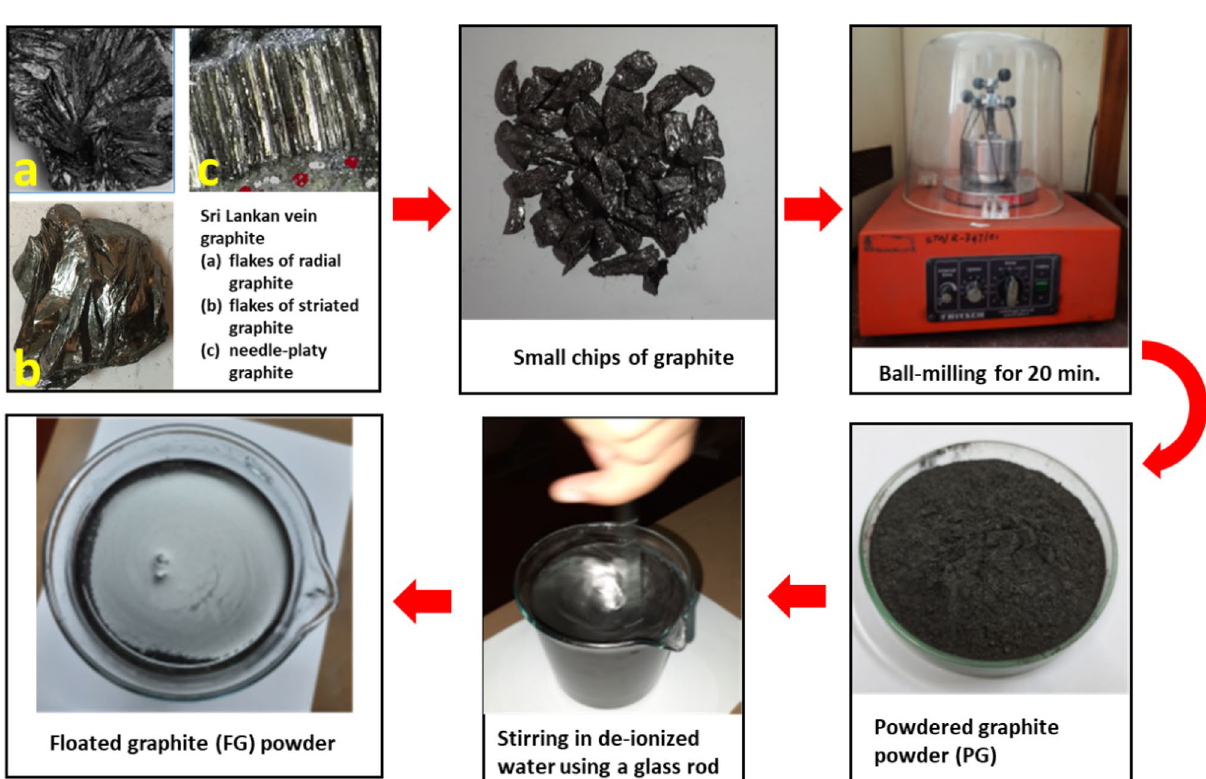
Figure 8. The process flow diagram of obtaining floated graphite from Sri Lankan vein